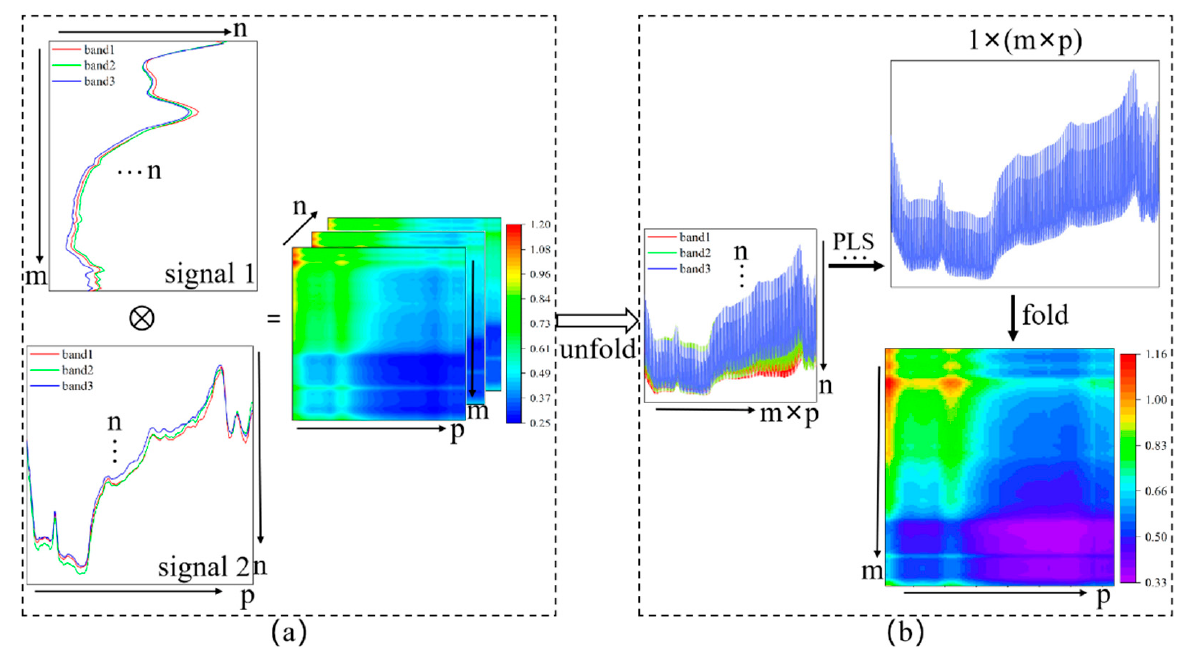
Figure 3. The process of spectral fusion by OPA ( a ), and the unfolding process of resulting matrices to build the OP matrix and apply statistical analyses ( b ). Here, “ n ” is the number of samples, “ m ” is the number of wavelengths for VIS–NIR, and “ p ” is the number of wavelengths for TIR.